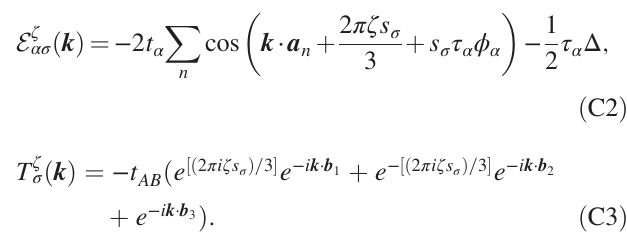
FIG. 10. Plot of the HF band structure (see accompanying discussion) at various interactions U The black dashed line indicates the Fermi energy at filling n ¼ 1 . Color indicates the sublattice content: The A sublattice is in red, and B in